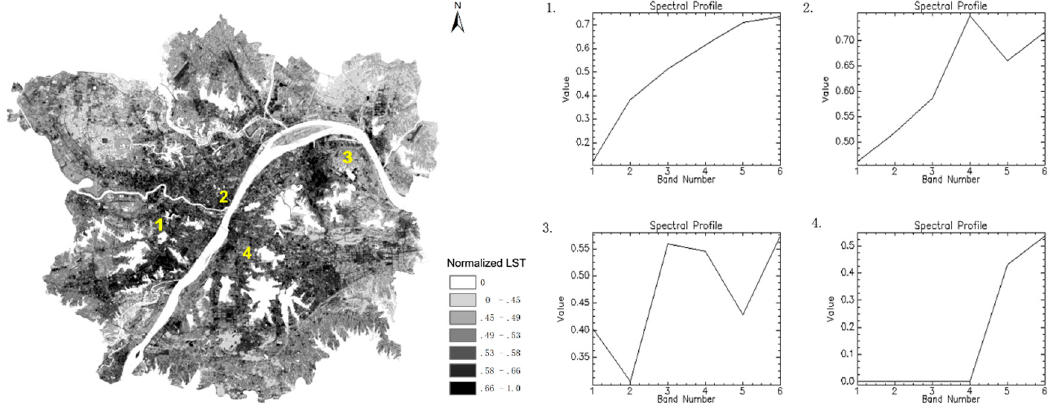
Figure 9. Normalized LST in 2014 with a sketch map of four defined situations. Figure 9 . Normalized LST in 2014 with a sketch map of four defined situations.